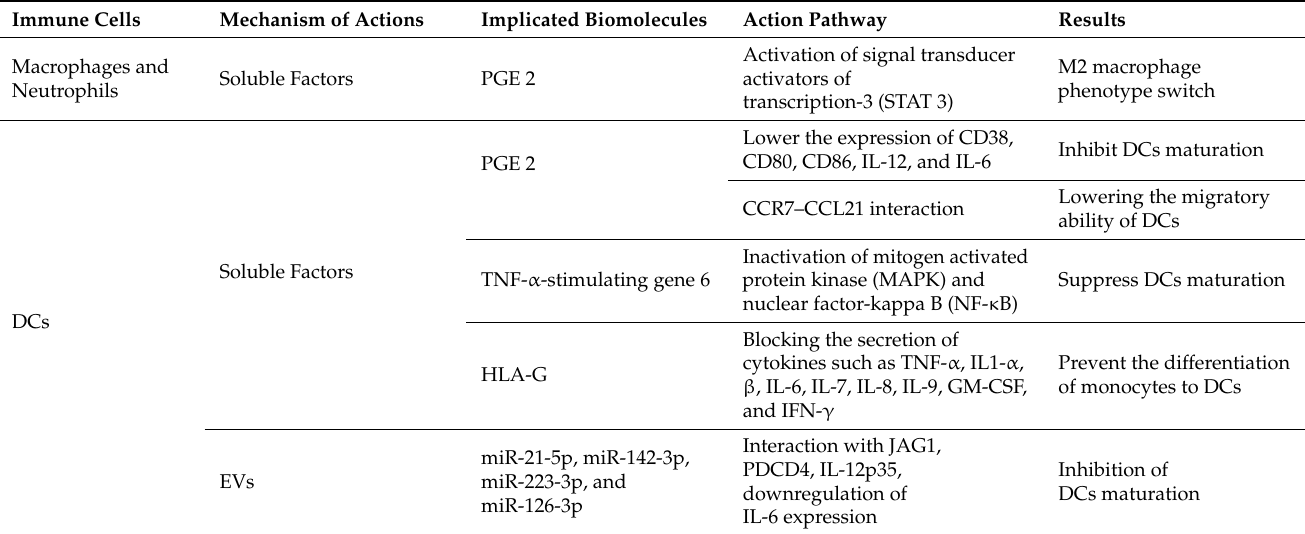
Table 3. Immunomodulation mechanisms of MSCs with various immune